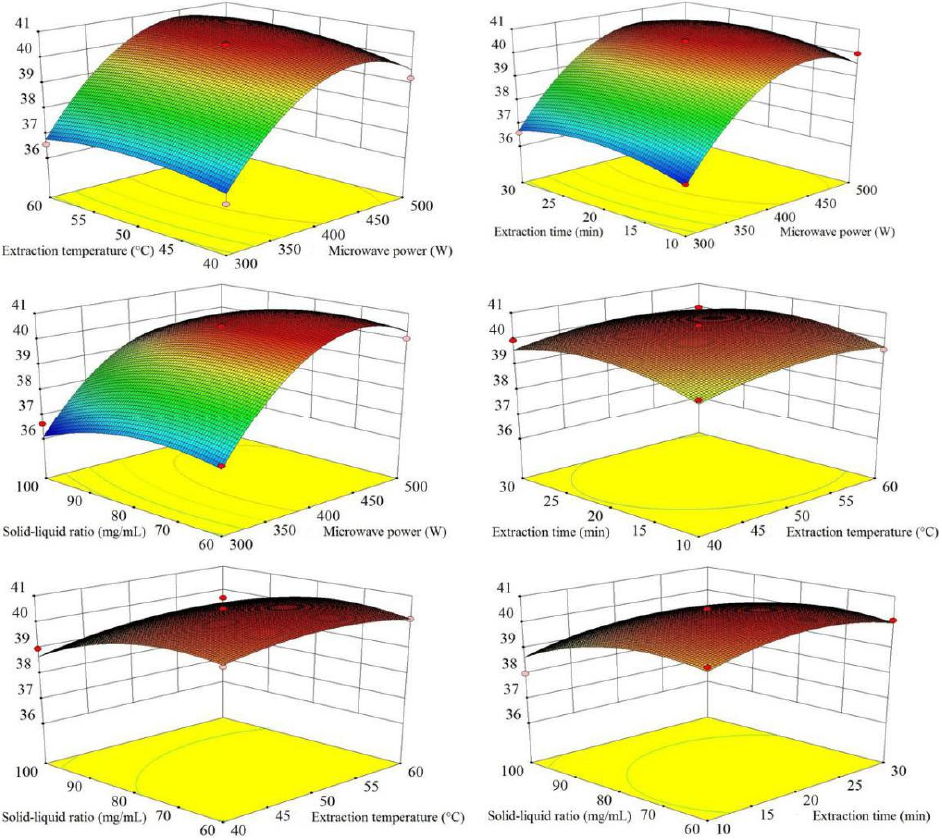
Figure 3. Three-dimensional (3D) response surface of the response surface design for NADES- Figure 3. Three ‐ dimensional (3D) response surface of the response surface design for NADES ‐ MAE optimization. X 1 , microwave power (W); X 2 , extraction temperature (°C); X 3 , extraction time MAE optimization. X 1 , microwave power (W); X 2 , extraction temperature ( ◦ C); X 3 , extraction time (min); X 4 , solid–liquid ratio (mg/mL). (min); X 4 , solid–liquid ratio